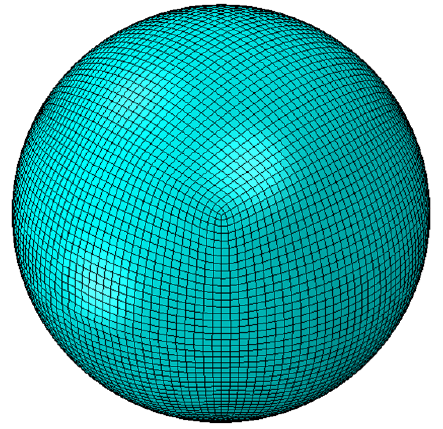
Figure 12. Load sphere mesh.